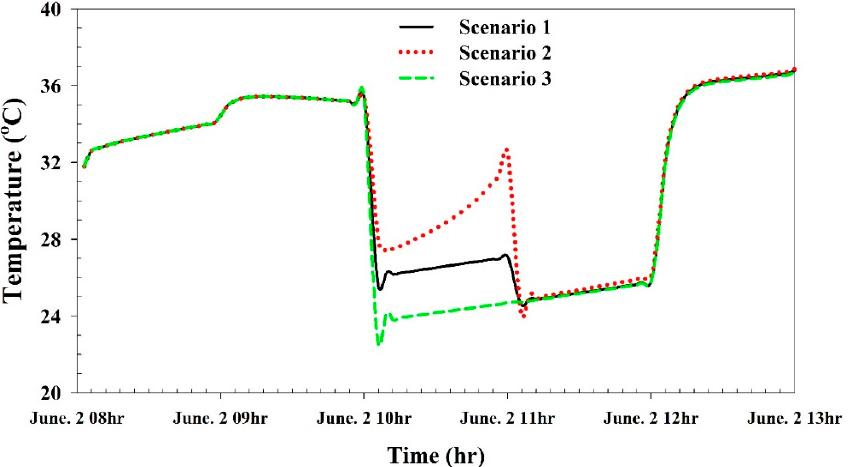
Figure 15. Greenhouse internal temperature for different natural ventilation scenarios.